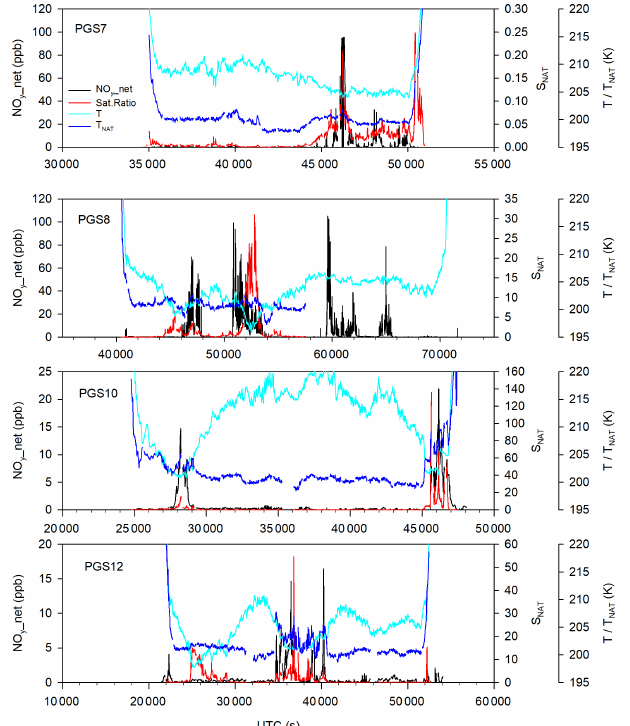
Figure 13. NO y _net, ambient temperature, saturation ratio, and T NAT for all flights where particulate nitrate was observed. During the second half of the flight, PGS flight 8 the NAT saturation tem- perature, T NAT , could not be calculated because of missing data.